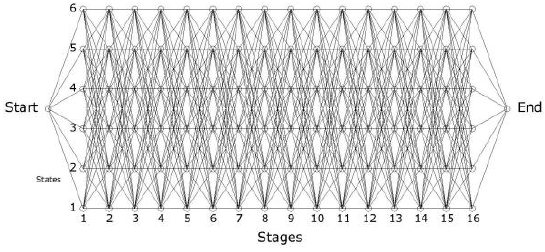
Fig. 3. The solution of the multiple objective MPP